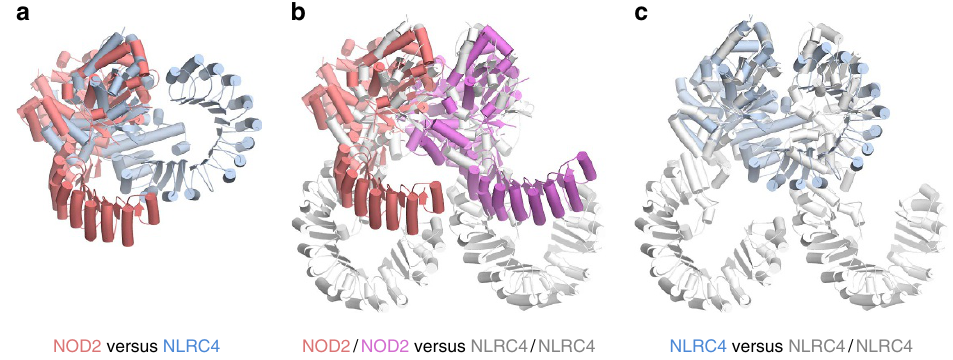
Figure 4 | Orientation of the LRR domain. ( a – c ) Superpositions of Oc NOD2 D CARD and inactive mNLRC4 D CARD ( a ), Oc NOD2 D CARD and NLRC4/NLRC4 lateral dimers of NLRC4–NAIP2 inflammasome ( b ), and inactive mNLRC4 D CARD and NLRC4/NLRC4 lateral dimers of NLRC4–NAIP2 inflammasome ( c ) using the NBD–HD1 regions for alignment (residues 195–485 and 95–355 for NOD2 and NLRC4, respectively). Oc NOD2 D CARD, inactive mNLRC4 D CARD and NLRC4 lateral dimers of NLRC4–NAIP2 inflammasome are shown in red/pink, light blue and grey,